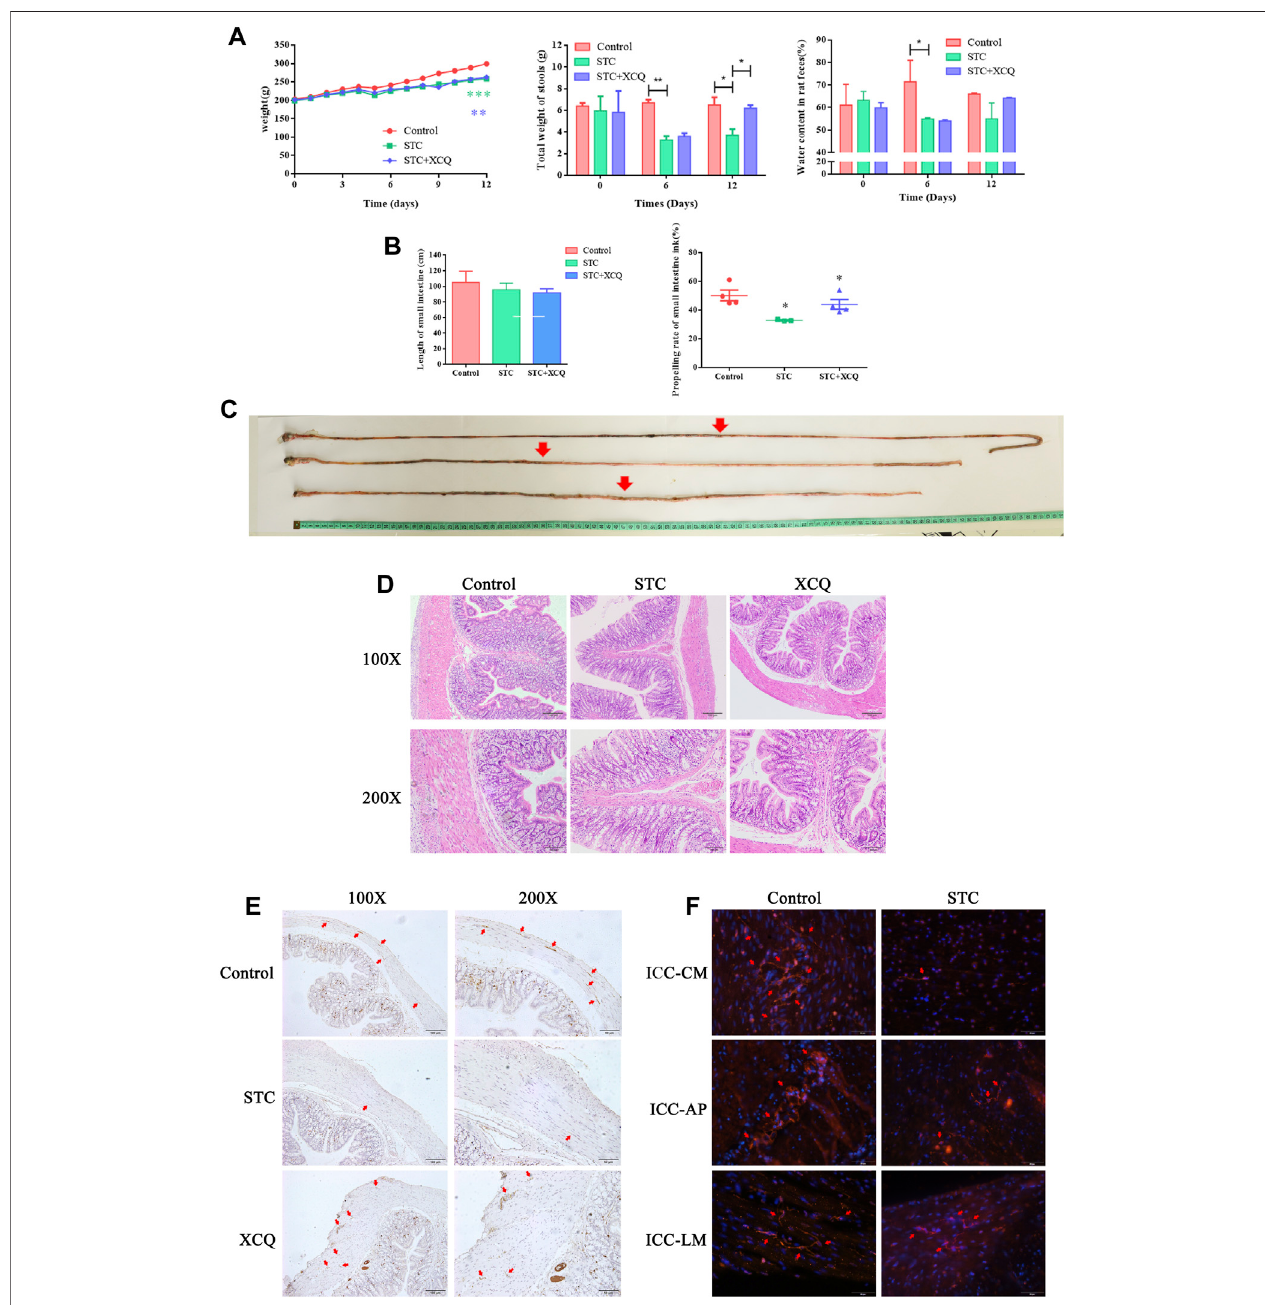
FIGURE 2 | Xiao Chengqi (XCQ) formula can improve defecation in slow transit constipation (STC) rats. (A) The physical signs of rats in each group include stable weightgrowth,andtheweightgrowthrateofratsinthenormalcontrolgroupisfaster.Thedataofeachgrouparecomparedwiththecontrolgroup.Thefecalweightand water content in the STC group are signi fi cantly lower than those in the control group, and the defecation weight in the XCQ group is signi fi cantly higher than that in the STC group, difference between Control and STC groups was showed as green asterisk, difference between Control and XCQ groups was showed as purple asterisk, * p < 0.05, ** p < 0.005; (B) The small intestine propulsion rate decreased in the STC group; (C) The intestinal propelling length of ink in each group; (D) HE staining of three groups of rat colon; (E) The expression of c-kit in muscle layer in the XCQ formula group was signi fi cantly higher than that in the STC group, the expression of c-kit was marked as red arrow; (F) expression changes in c-kit in the colon tissue of STC patients, the expression of c-kit was marked as red arrow.